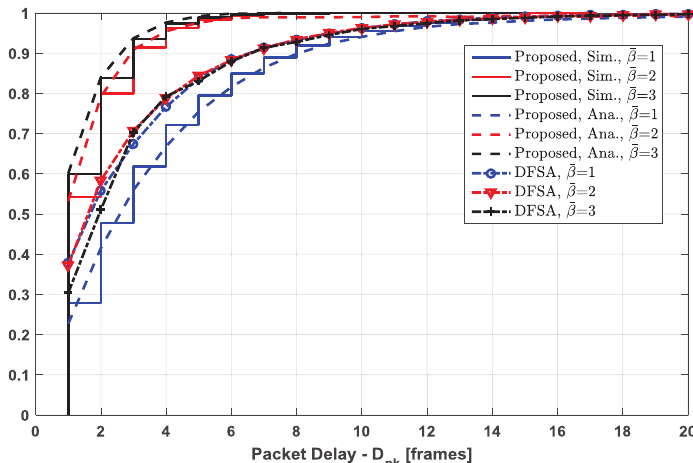
Figure 8. Packet delay cumulative distribution for the proposed scheme and DFSA with number of EH-STs U = 200 under different EH rates ¯ β ∈ { 1,2,3 } , e max = 10. For access schemes, number of time slots in each frame N = 200 (only for the proposed scheme. For DFSA, the packet delay in frames